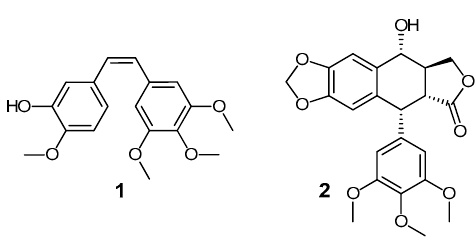
Figure 1. Structures of Combretastatin A4 (CA-4, 1 ) and podophyllotoxin 2 .